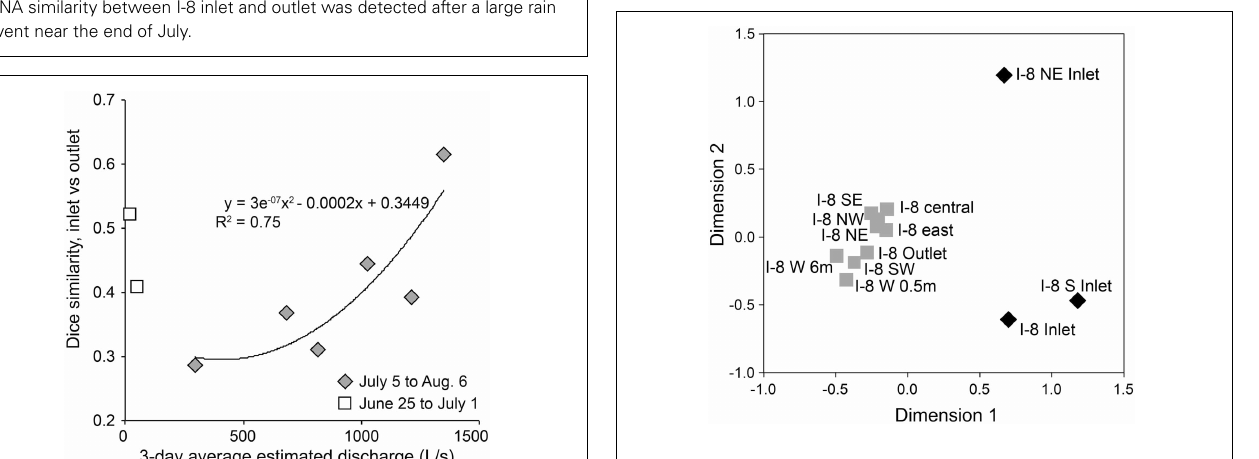
FIGURE 7 | NMDS of bacterial communities at Lake I-8 on 4 July 2007 determined from Dice similarities of 16S rRNA DGGE banding patterns for Inlet samples (black diamonds) and outlet and lake samples (gray squares). All samples were collected from surface water (0.01m for streams, 0.5m for lake) unless otherwise noted. Normalized raw stress =